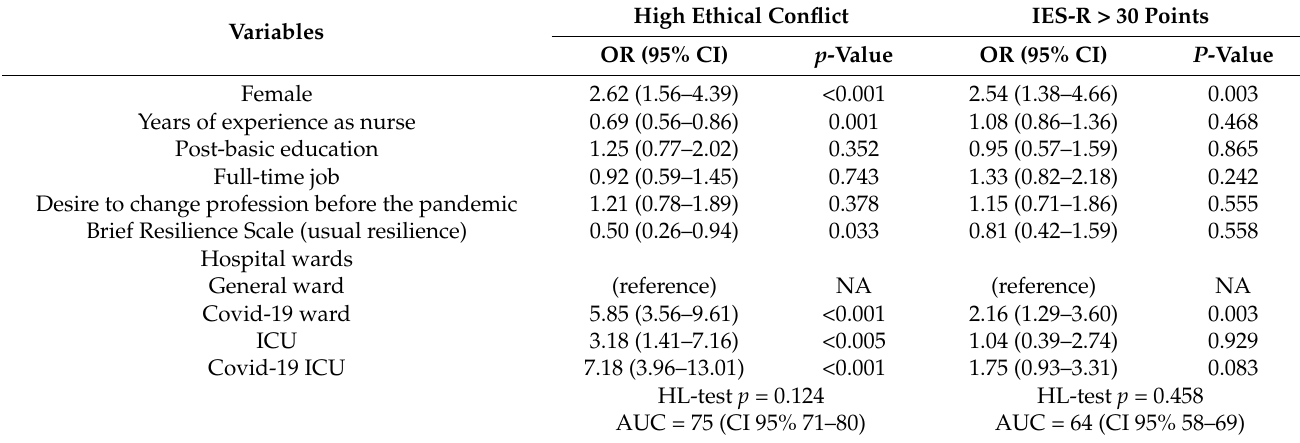
Table 5. Predictive variables of high ethical conflict and high levels of psychological